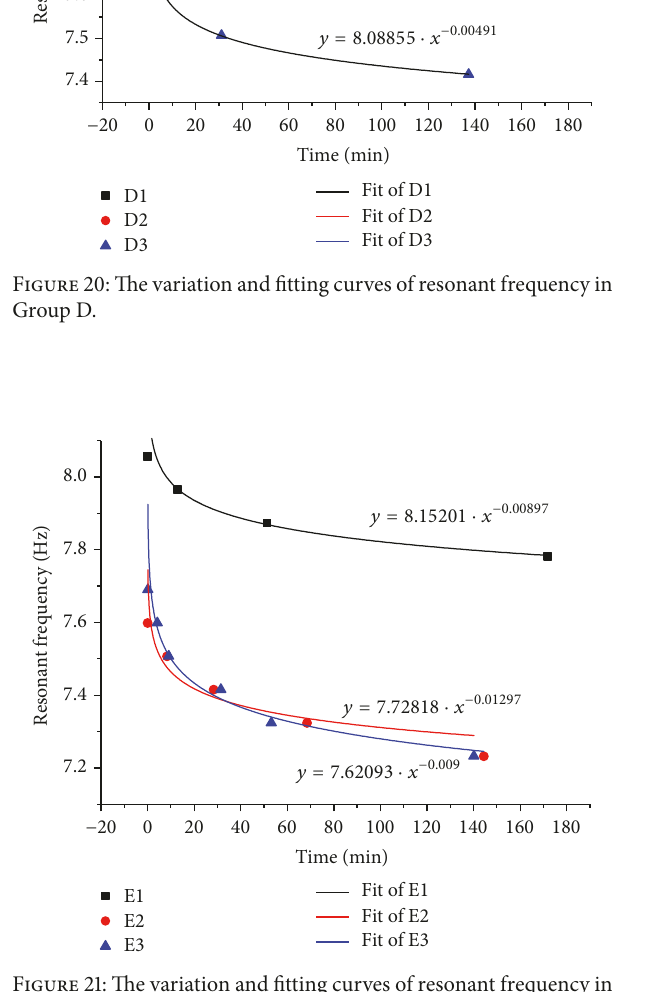
Figure 21: The variation and fitting curves of resonant frequency in Group